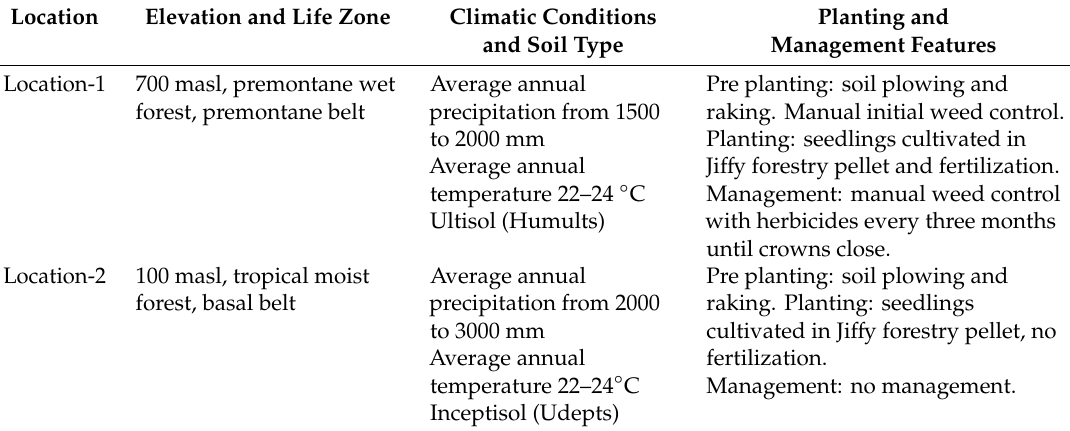
Table 1. Climatic, planting, and management conditions of short-rotation Gmelina arborea Roxb. plantations in two di ff erent location in Costa Rica.